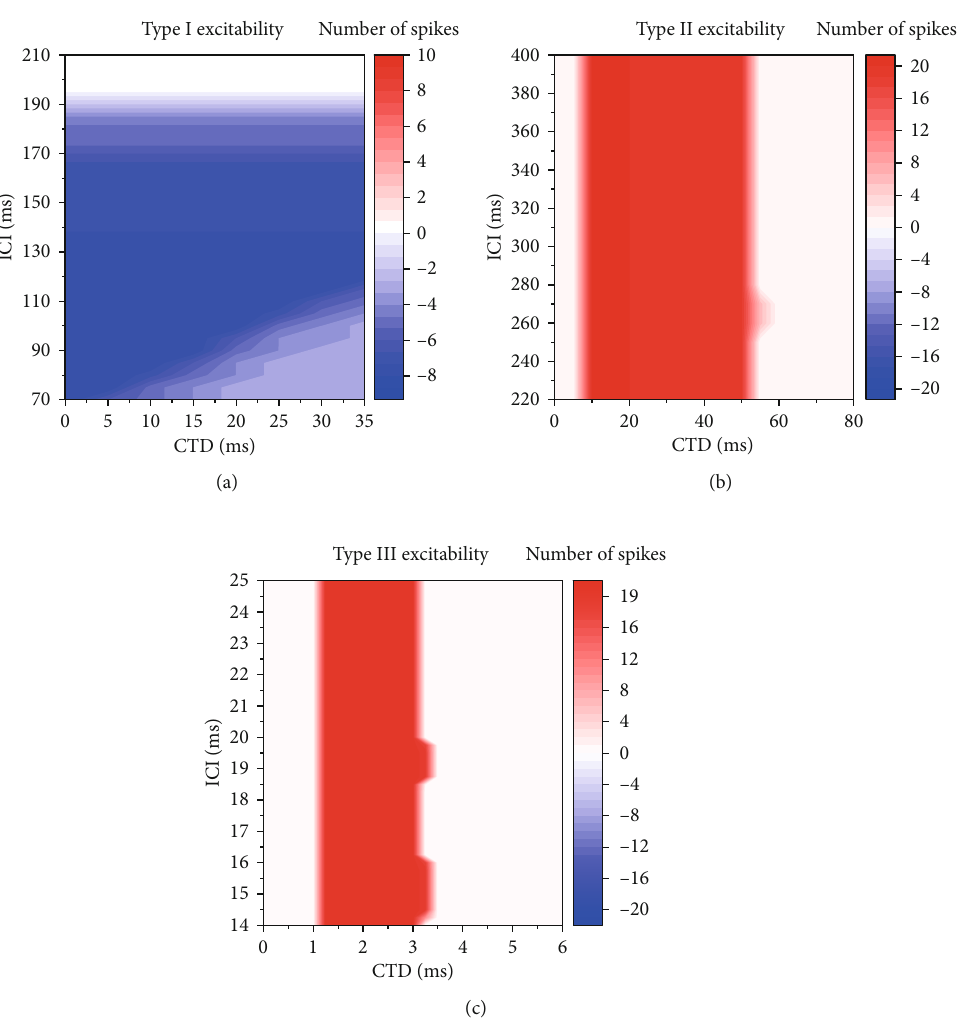
Figure 3: The changes of the fi ring rate after introducing the inhibitory stimulations in the (CTD, ICI) plane for three types of excitability. (a) Type I excitability with G ex = 1 : 1 mS/cm 2 and G inh = 0 : 8 mS/cm 2 ; (b) type II excitability with G ex = 1 : 1 mS/cm 2 and G inh = 3 : 1 mS/cm 2 ; (c) type III excitability with G ex = 3 mS/cm 2 and G inh = 1 : 1 mS/cm 2